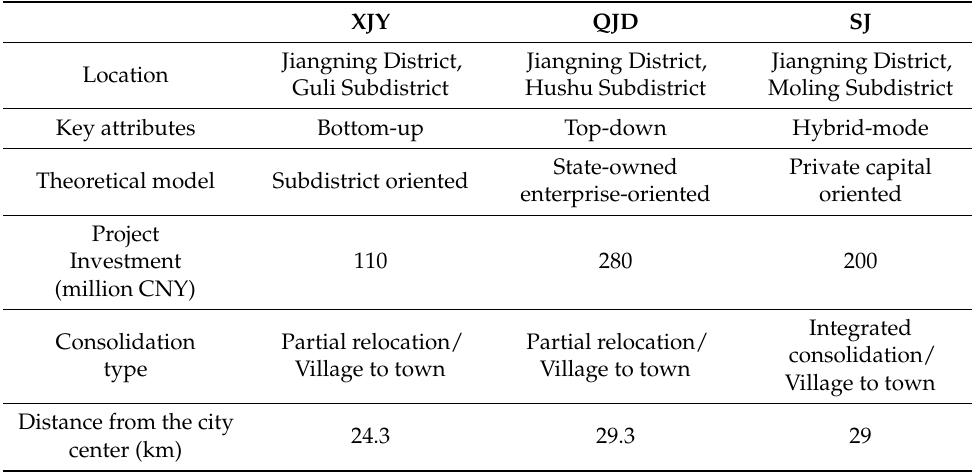
Figure 3. Location of the three case study areas. Table 1. Essential characteristics of the three case study areas.